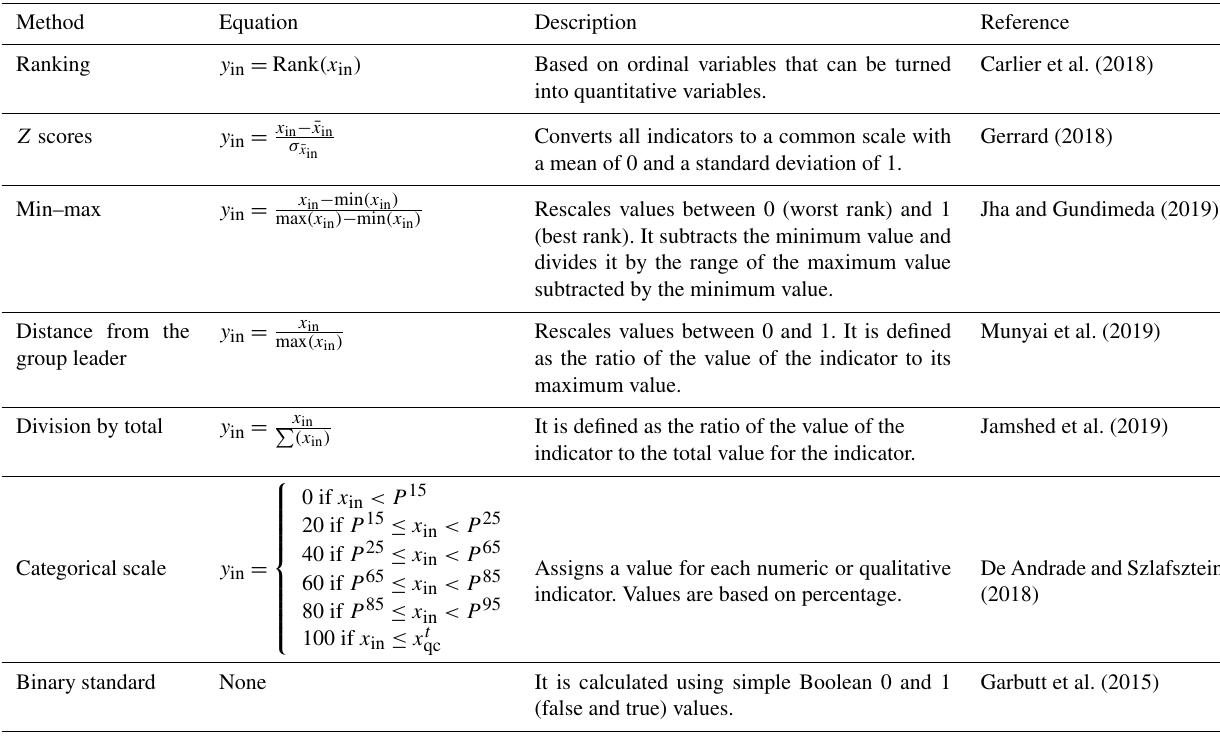
Table 1. Characteristics of the main normalization methods used for building indices.